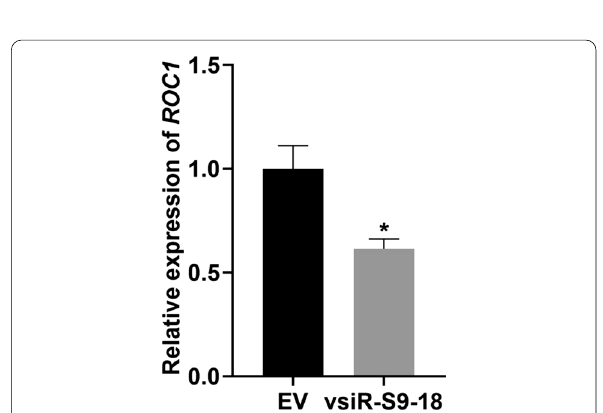
Fig. 3 RT-qPCR detection of ROC1 expression in rice protoplasts. Total RNAs were extracted from the rice protoplasts expressing EV or vsiR-S9-18 plasmid at 16 h. The values shown are the means (n 3). Student’s t test was used for the analyses (* P < =